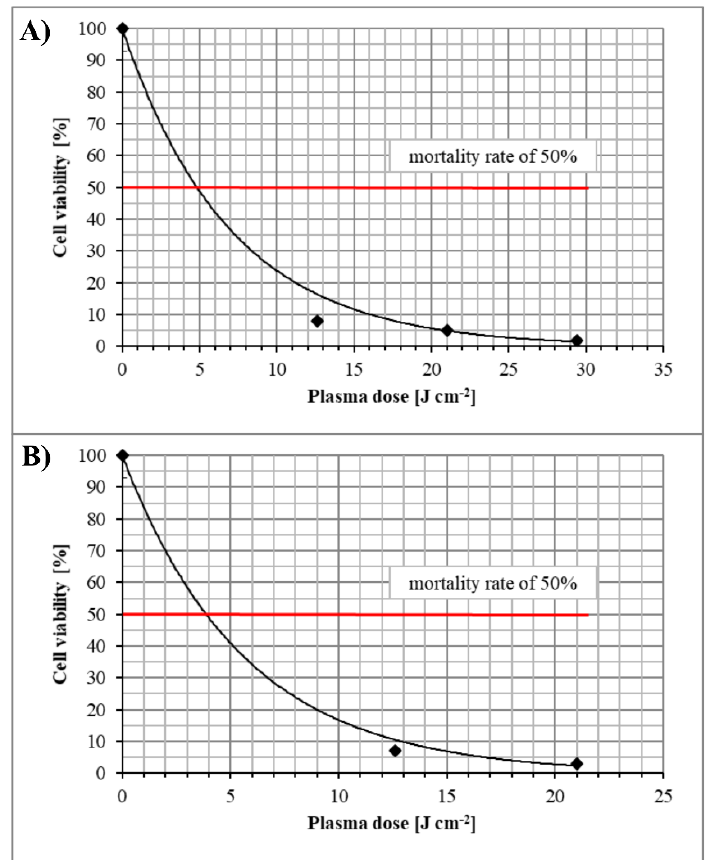
Figure 3. The effect of nonthermal plasma on the destruction of viable microbial cells forming fouling after 4-h contact of the activated sludge with: ( A ) polyamide membrane (PA); ( B ) cellulose acetate membrane (CA).